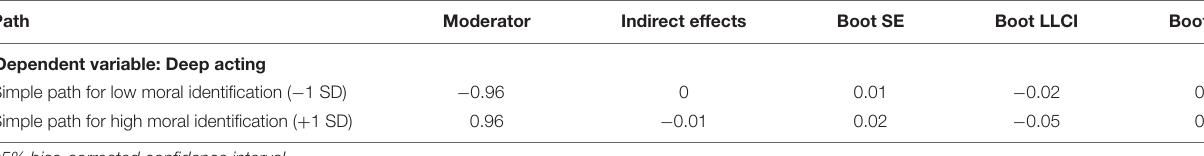
TABLE 3A | Conditional indirect effects of CSR perception on deep acting at values of moral identification. Path